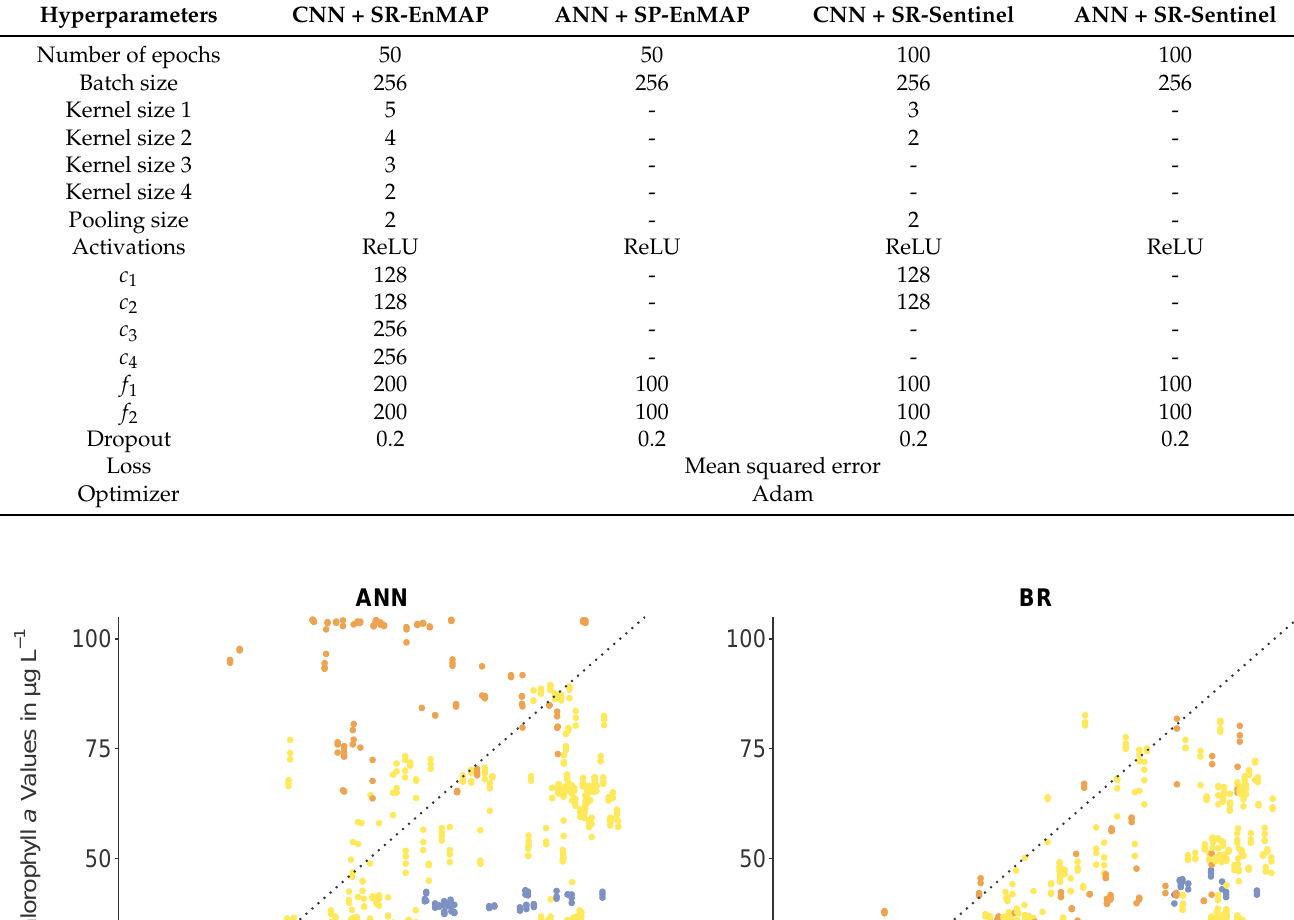
Table A2. Hyperparameters of the one-dimensional convolutional neural network (1D CNN) (here: CNN) and the artificial neural networks (ANN) with their respective simulated spectral resolutions. The number of filters in the I -th CONV layer is defined as c i and the number of units in the I -th FC layer is defined as f j .